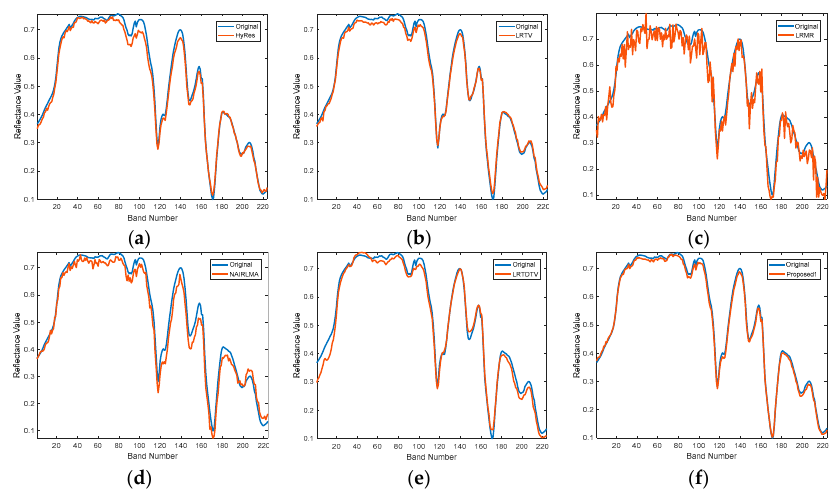
Figure 6. Full band spectral reflectance curve at a spatial position (55, 55): ( a ) HyRes, ( b ) LRTV, ( c ) LRMR, ( d ) NAIRLMA, ( e ) LRTDTV, and ( f ) proposed.